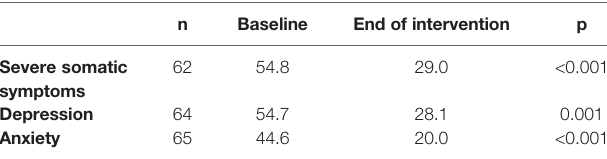
McNemar test; exact signi fi cance